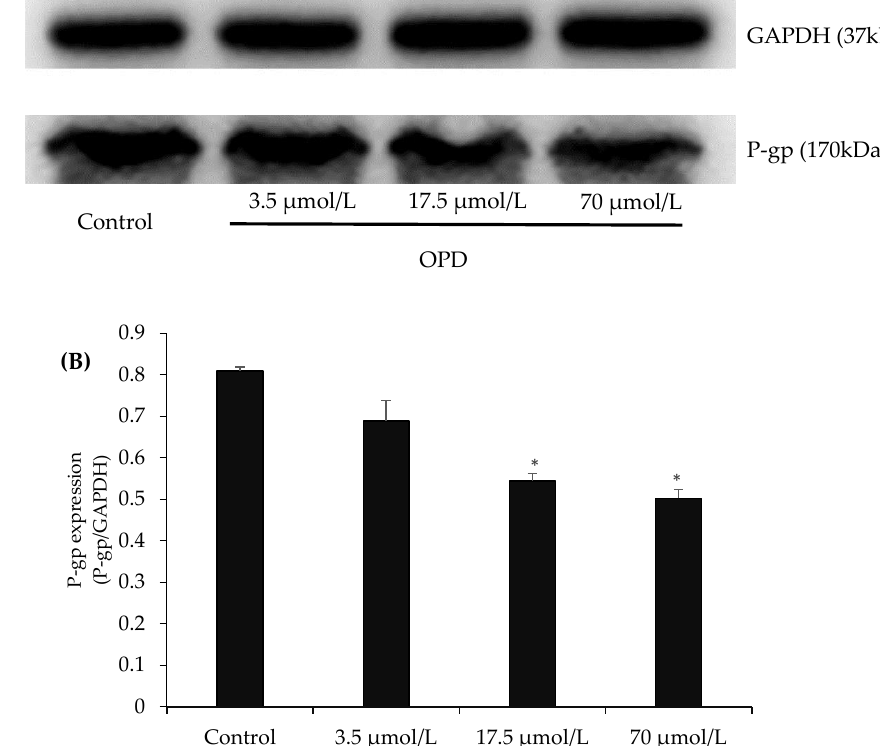
Figure 3. Effects of OPD on P-gp expression in MDCK-MDR1 cells: ( A ) representative P-gp expression by western blot on MDCK-MDR1 treated with different concentration of OPD; and ( B ) quantitative data of P-gp expression. Values are mean ± SD ( n = 3). Differs from control group: * p < 0.05.